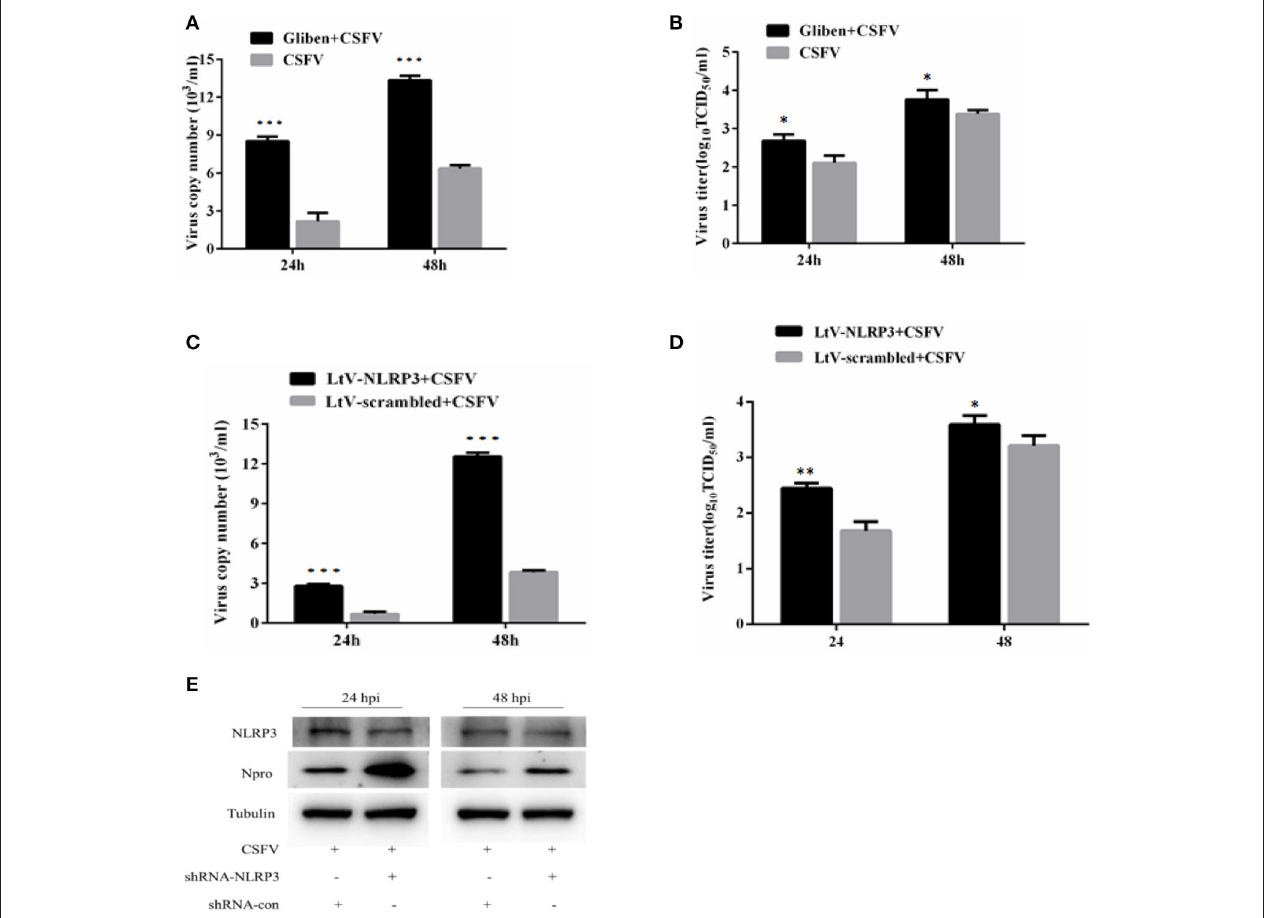
FIGURE 7 | Inhibition of NLRP3 promoted the replication of CSFV. The effect of the NLRP3-specific inhibitor glibenclamide on the virus copy number (A) and virus titers (B) in CSFV-infected cells. PBMCs were treated with glibenclamide or DMSO for 24h, followed by the cells being infected with CSFV (MOI = 1). At 24h pi and 48h pi, the levels of CSFV RNA were analyzed using real-time reverse transcription polymerase chain reaction (RT-qPCR) and CSFV titers were analyzed by immunofluorescence (mean ± SD; n = 3; * P < 0.05. P -values were calculated using an One-way ANOVA test. ** P < 0.01; *** P < 0.001). The effect of the NLRP3-specific inhibitor shRNA on the virus copy numbers (C) , virus titers (D) , and levels of virus protein (E) in CSFV-infected cells. PBMCs were transfected with LtV-scramble or Ltv-NLRP3 for 24h, followed by CSFV infection (MOI = 1). At 24h pi and 48h pi, the levels of CSFV mRNA, CSFV titers, and Npro protein levels were analyzed (mean ± SD; n = 3; * P < 0.05. P -values were calculated using an One-way ANOVA test. ** P < 0.01; *** P <